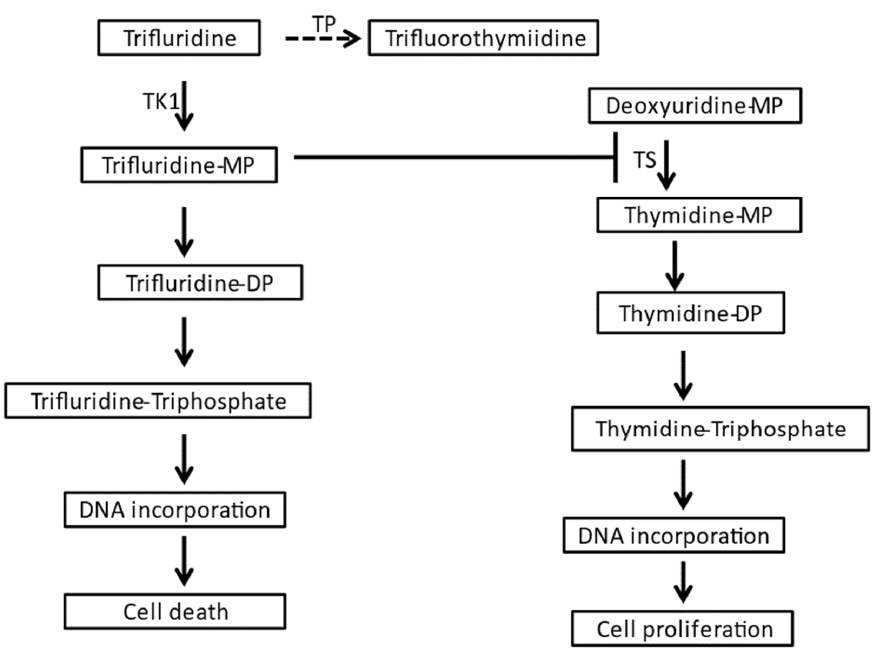
Figure 2. Pathways of trifluridine metabolism and action. DP: biphosphate, MP: monophosphate, TK1: thymidine kinase 1, TP: thymidine phosphorylase, TS: thymidine synthetase.